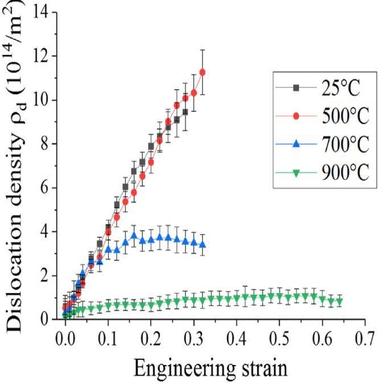
Evolution of dislocation density during tensile test at different temperatures.